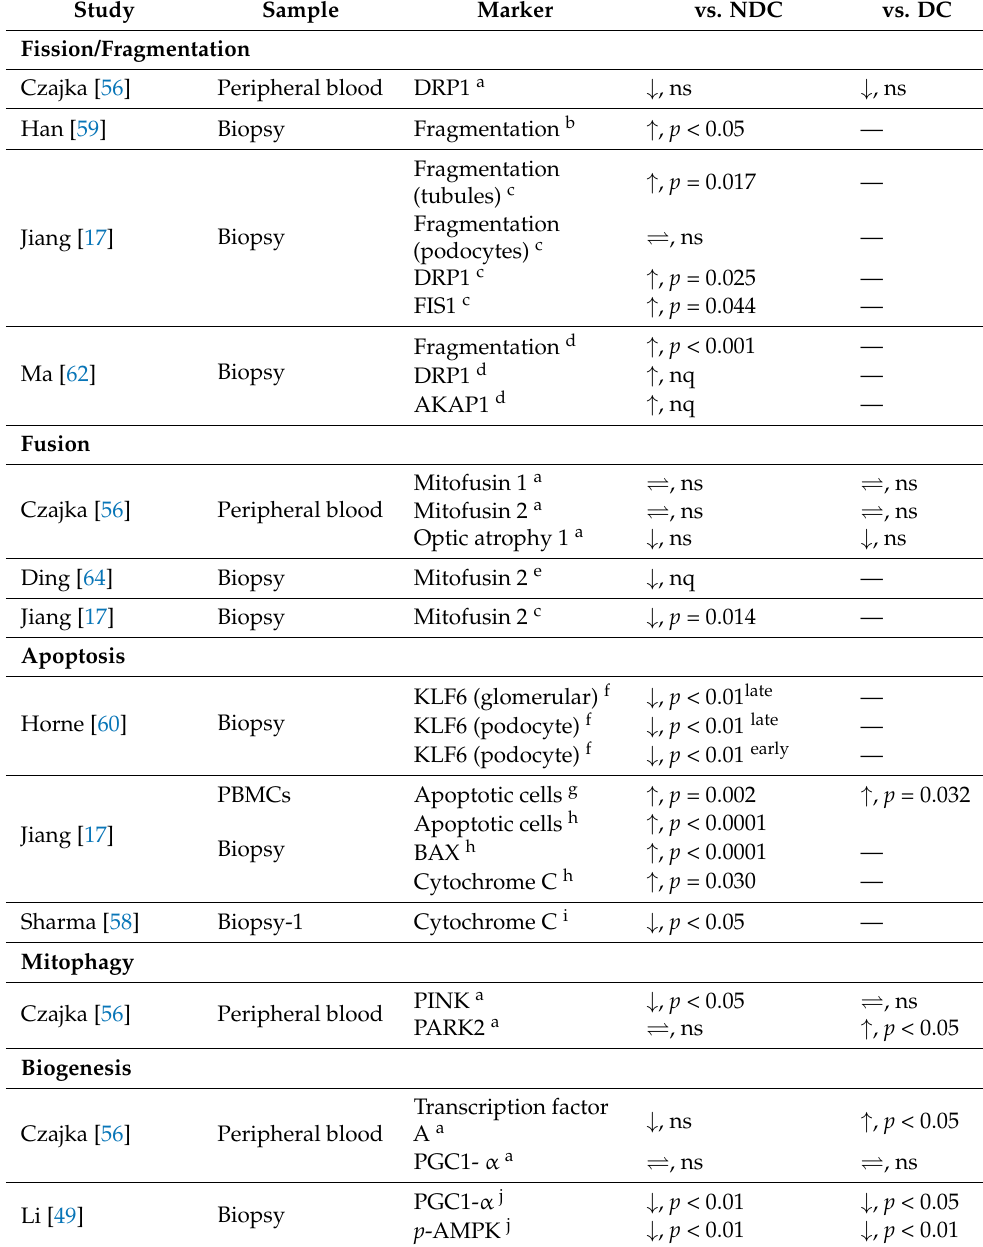
Table 3. Summary of mitochondrial dynamics (i.e., fission, fragmentation, fusion, apoptosis, mi- tophagy, biogenesis) in individuals with DKD compared to NDC and/or DC. Study Sample Marker vs.